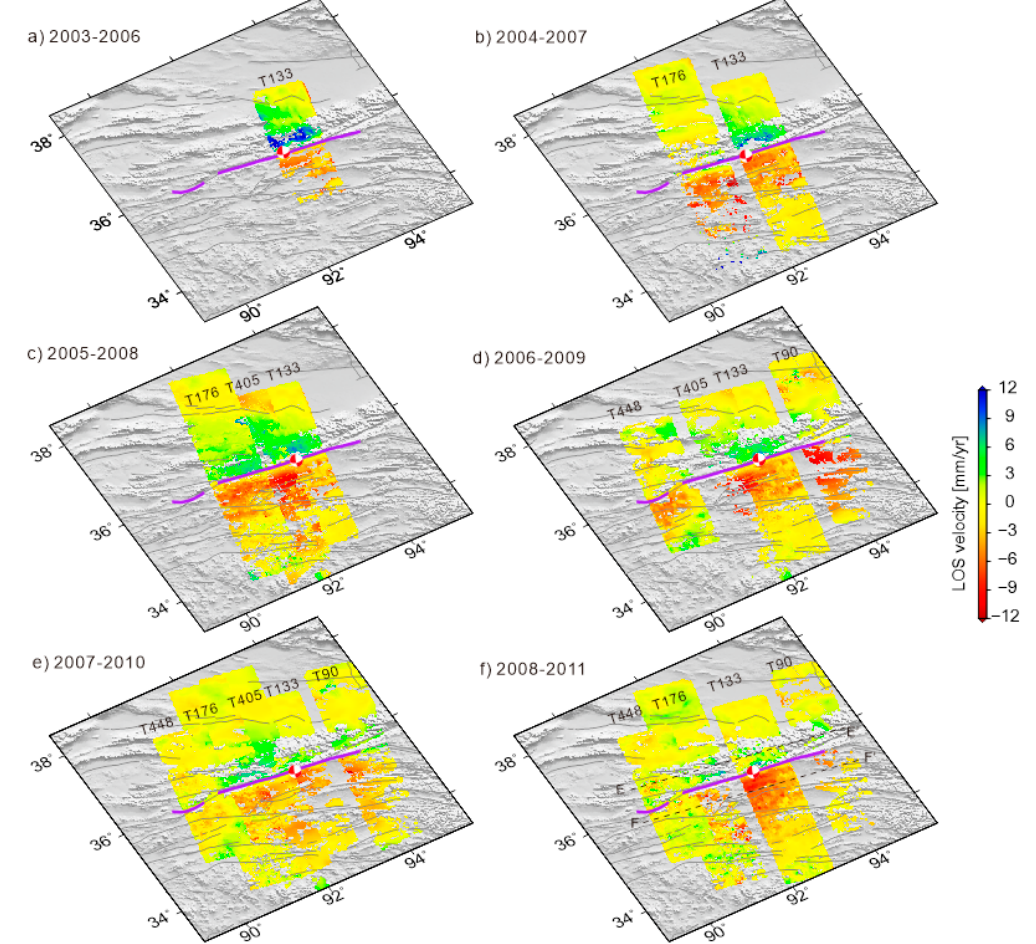
Figure 11. InSAR postseismic velocity maps in different periods following the 2001 event covering the whole rupture on five overlapping tracks: ( a ) 2003–2006; ( b ) 2004–2007; ( c ) 2005–2008; ( d ) 2006–2009; ( e ) 2007–2010 and ( f ) 2008–2011. The purple lines denote the 2001 surface rupture. The beach ball represents the focal mechanism of the 2001 event. The black dash lines in ( f ) are profile locations along the